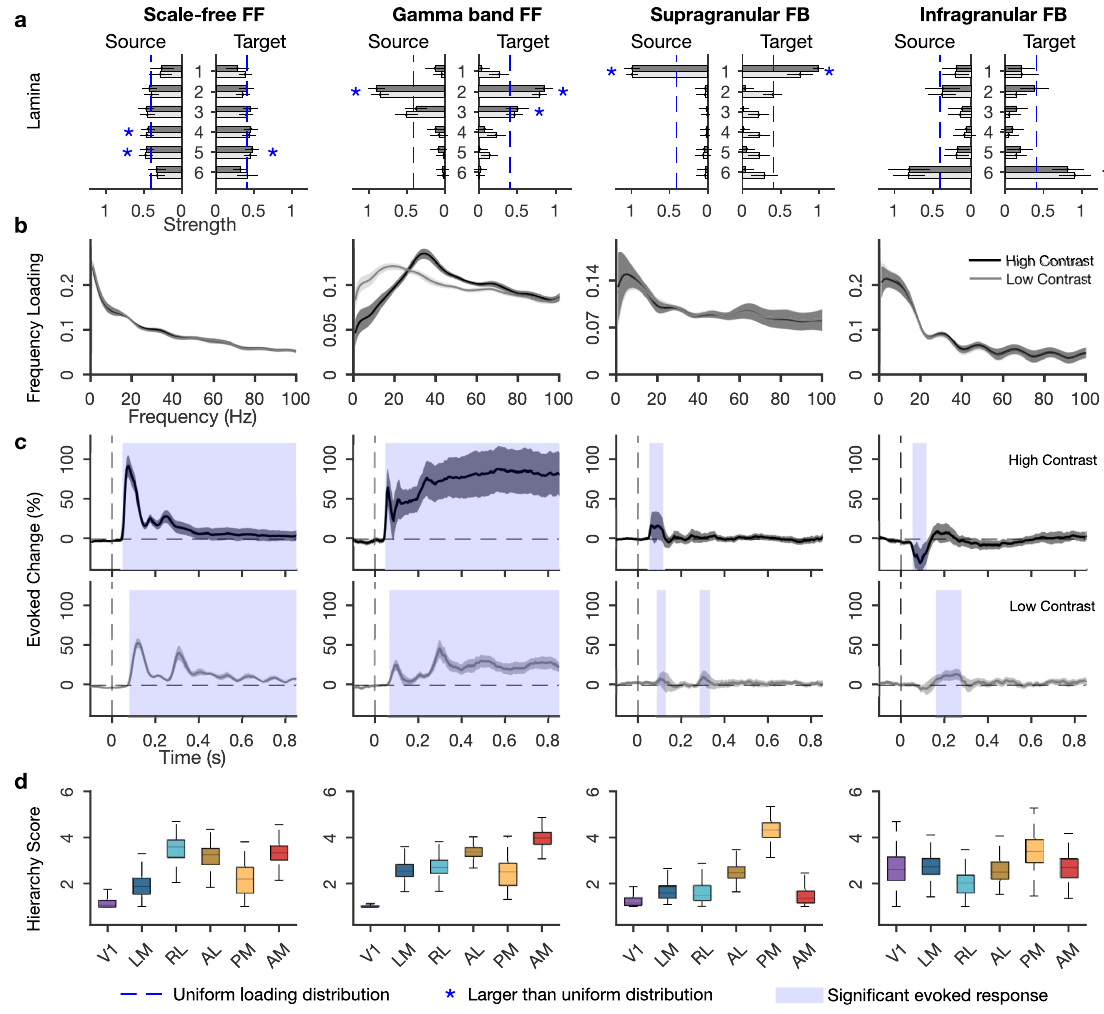
Fig 3. Four concurrent functional networks in visual cortex. (a) Laminar input and output strengths (loadings) for the 2 FF and 2 FB networks. Blue stars indicate layers with larger amplitude than the uniform distribution, calculated based on 95% confidence interval. (b) Frequency distributions of each network. (c) Temporal dynamics per network, as percentage of change compared to prestimulus period, calculated from temporal loadings. Shading indicates statistically significant increases from baseline. (d) Functional hierarchy scores calculated from between-area connectivity loadings (see Methods). The higher and lower limits of box plots indicate bootstrapped 25 and 75 quantiles of the hierarchy scores, and whiskers indicate extreme values excluding outliers. For a, b, and c, error bars and gray shading indicate SDs over bootstraps ( n = 500). Underlying data: https://osf.io/pqf7z. FB, feedback; FF, feedforward.